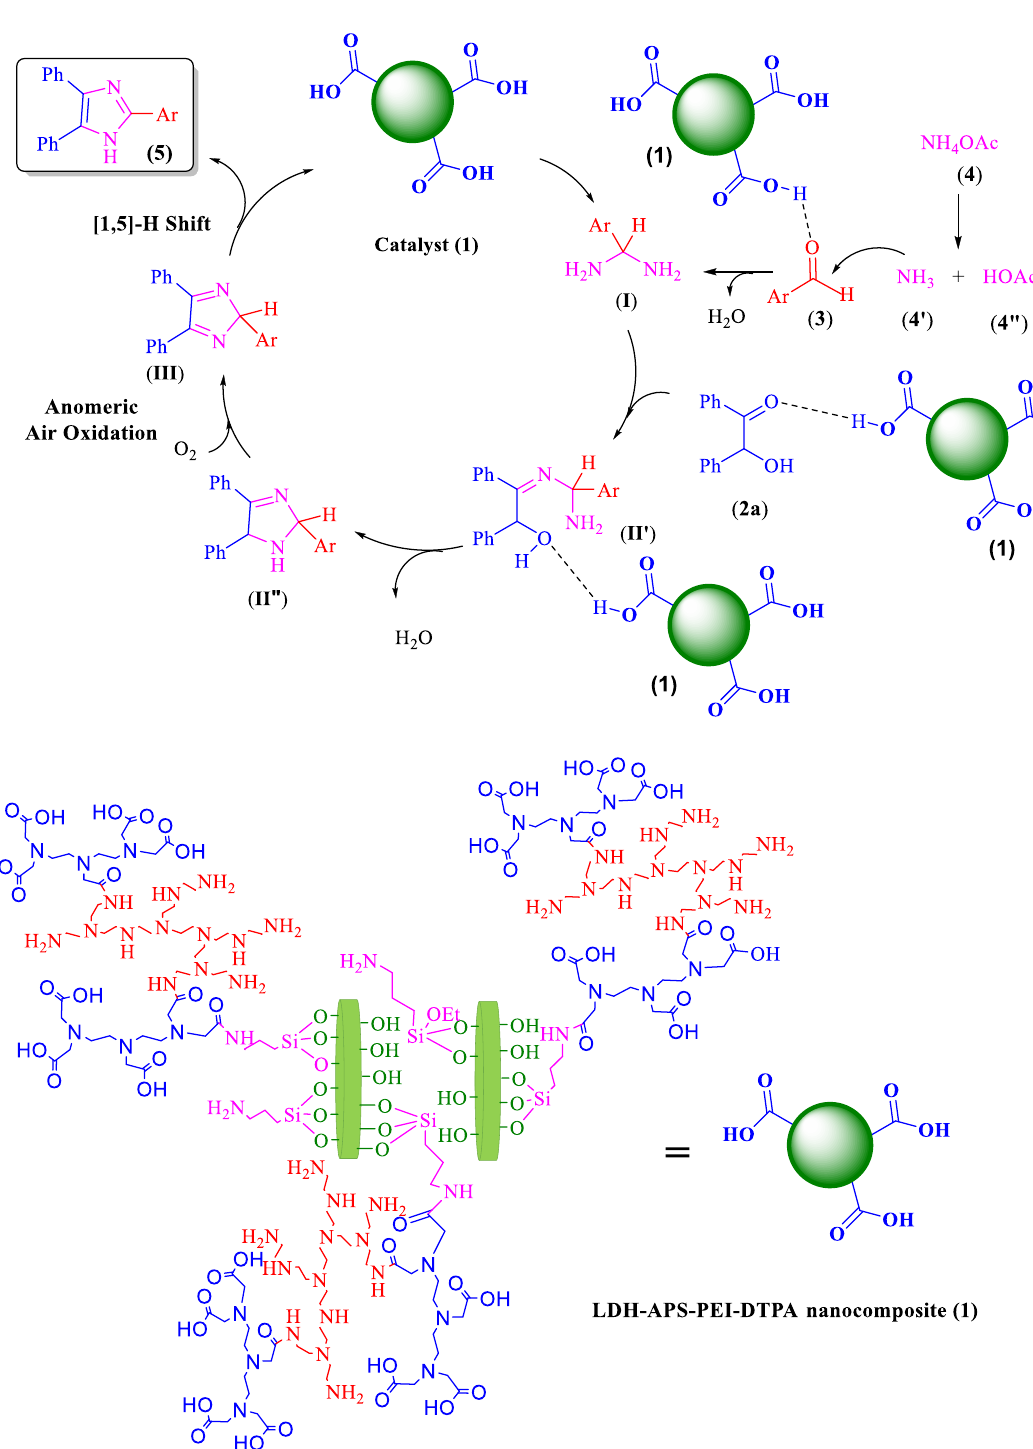
Figure 8. The proposed mechanism for the synthesis of imidazole derivatives using benzoin in the presence of LDH–APS–PEI–DTPA nanocomposite ( 1 )